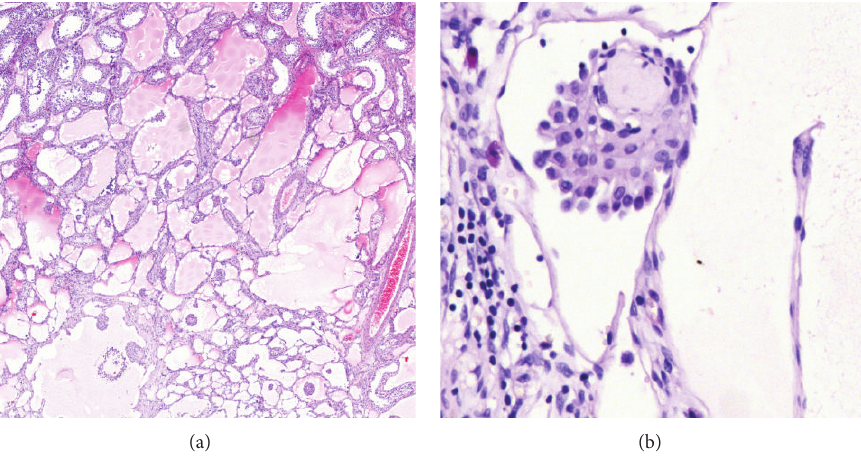
Figure 1: Histomorphology. (a) HE stain 2.5x; (b) HE stain 40x. Images show tumor in relation to adjacent testicular tissue: cavernous vessel structures with prominent intraluminal papillae composed of plump rounded cells with eosinophilic cytoplasm.